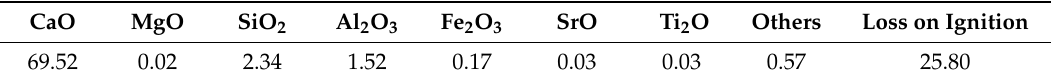
Table 1. Chemical components of raw carbide slag